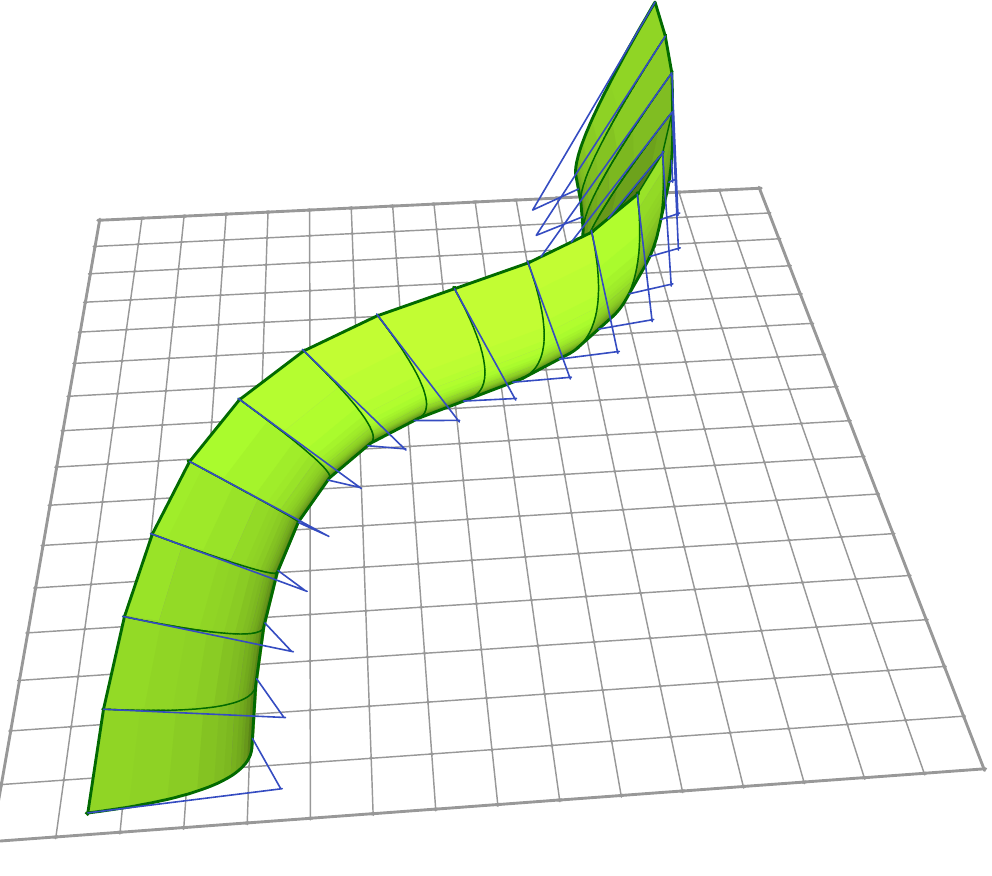
Figure 17. Developed surfaces created using method